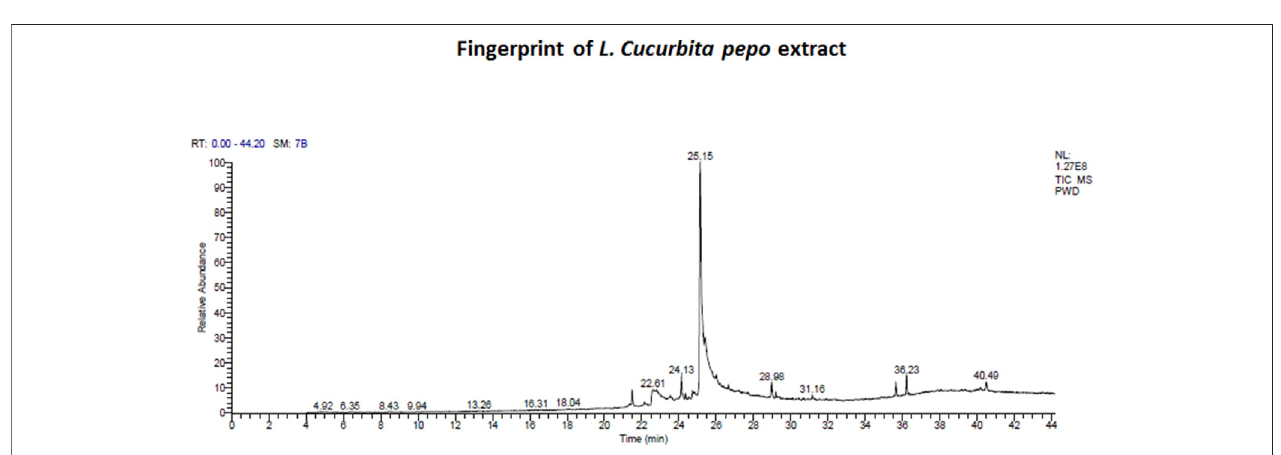
FIGURE 2 | Fingerprint of chromatogram of L. Cucurbita pepo extract prepared by using a trace gas chromatography mass spectrometer.